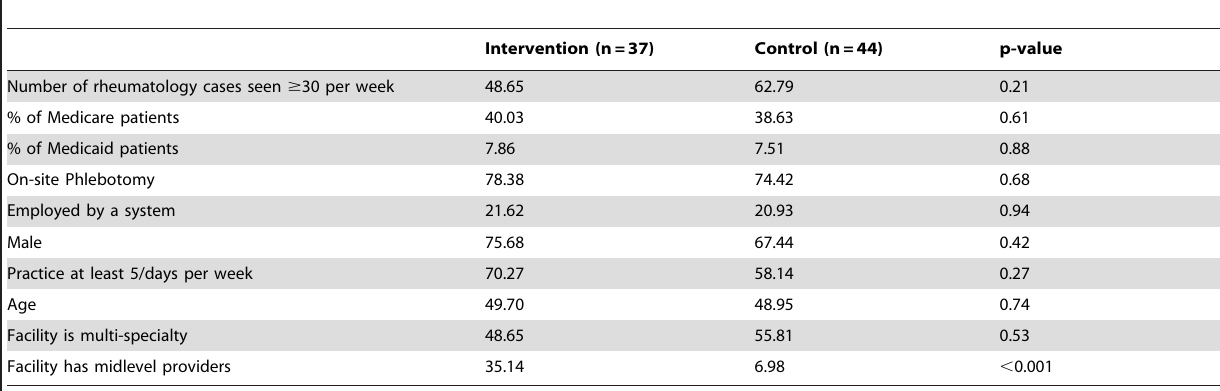
Table 1. Baseline Characteristics of Intervention and Control group physicians, All Case types.